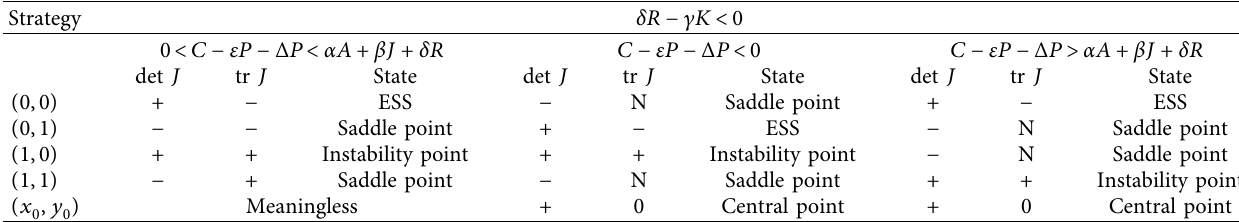
Table 4: Local stability analysis between the governments and enterprises.